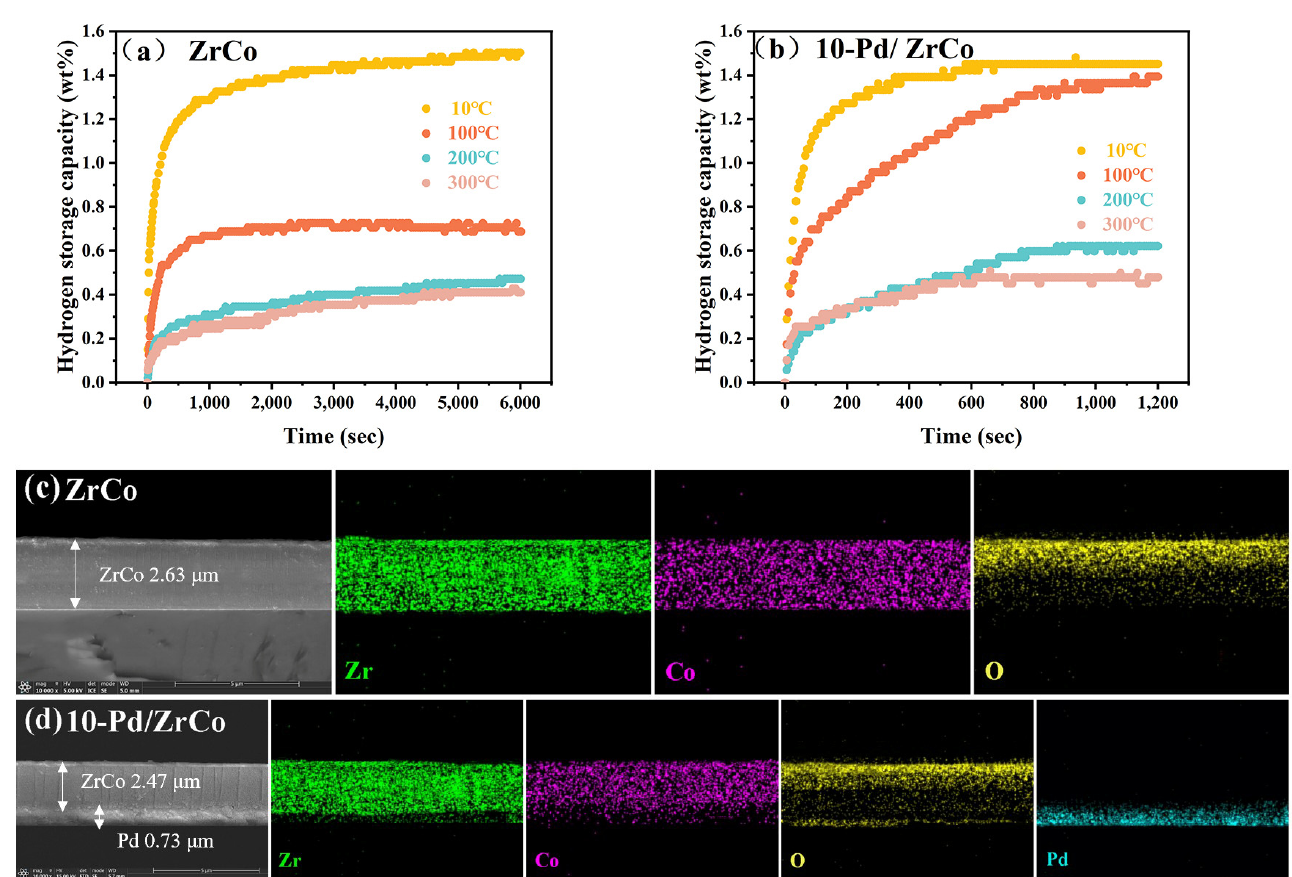
Figure 4. ( a , b ) Hydrogen absorption curves of ZrCo and 10-Pd/ZrCo after poisoning at 10 °C, 100 °C, 200 °C, and 300 °C; ( c , d ) SEM–EDS elemental mapping of the cross-sections of the ZrCo and 10-Pd/ZrCo films after poisoning at 100 °C.